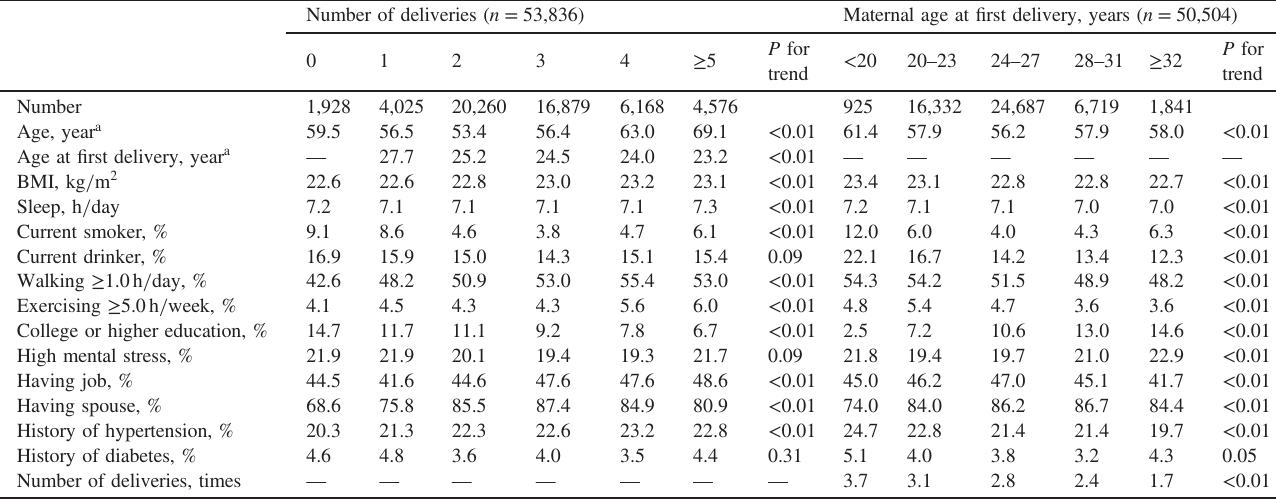
Table 1. Age and age-adjusted baseline characteristics of participants according to the number of deliveries and maternal age at fi rst